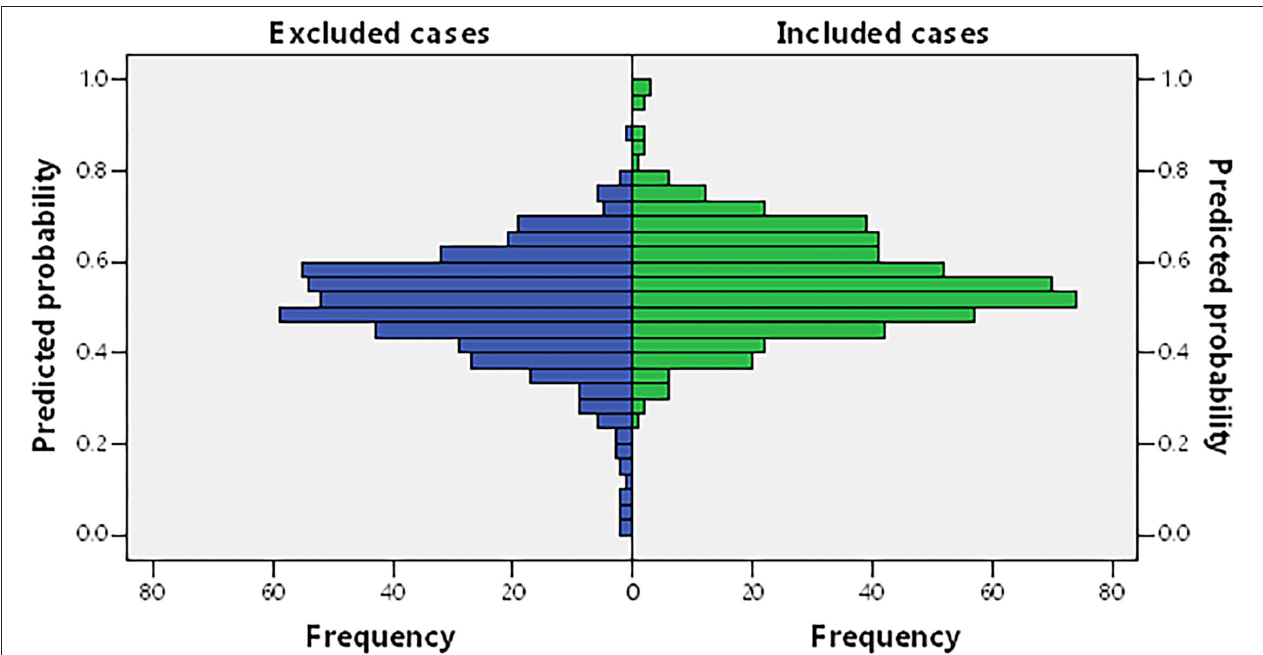
FIGURE 2 | Propensity score of included cases and excluded cases, from demographic and clinical characteristics and the routine serum test. Including age, gender, hypertension, diabetes, coronary artery disease, atrial fibrillation, hyperlipidemia, history of smoking and drinking alcohol, weight, National Institutes of Health Neurological Deficit Score (NIHSS) score at admission and discharge, mean blood pressure (MBP), left ventricular ejection fraction (LVEF), fasting blood glucose (FBG), 2-h post-meal blood glucose (P2hPG), glycated hemoglobin (HbA1c%), total cholesterol (TC), low-density lipoprotein cholesterol (LDL), high-density lipoprotein cholesterol (HDL), cell count of white blood cell (WBC), neutrophil, lymphocyte, red blood cell (RBC), and blood platelet (PLT), hemoglobin (HB), total serum protein (TP), albumin, total prothrombin time (PT), international normalized ratio (INR), activated partial thromboplastin time (APTT), fibrinogen (FIB), urea nitrogen (BUN), creatinine (Cr), homocysteine (HCY), thyroid-stimulating hormone (TSH), free triiodothyronine (FT3), and free tetraiodothyronine